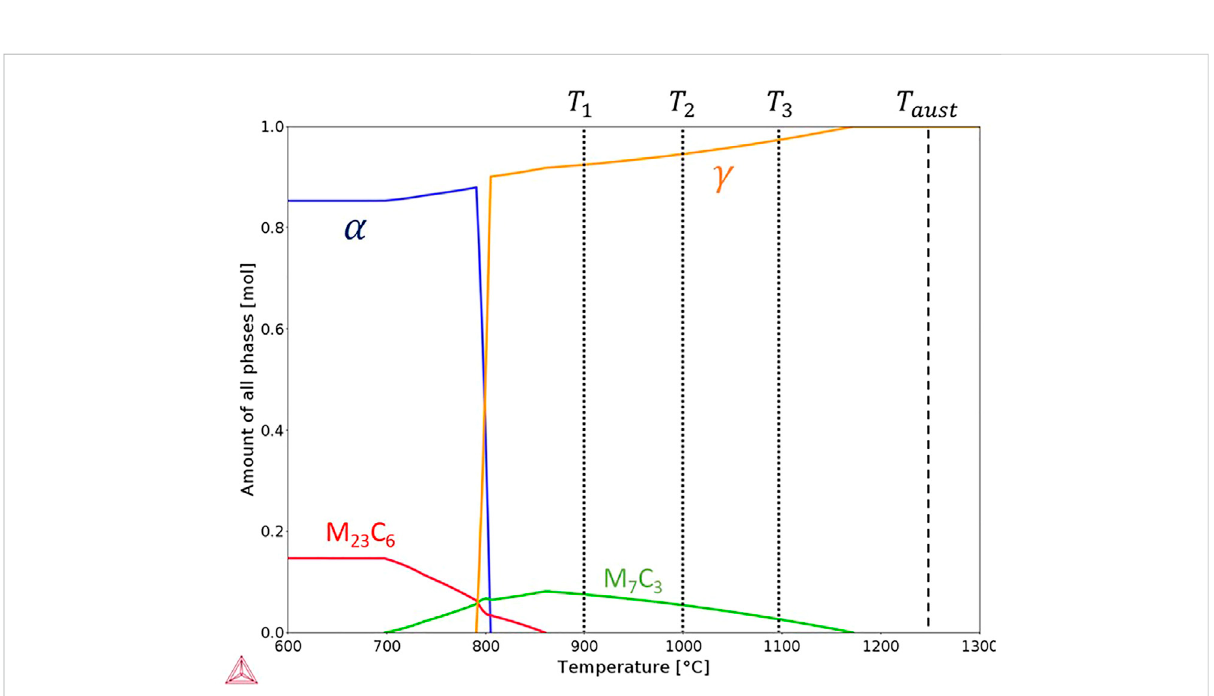
FIGURE 2 Equilibrium property diagram of Fe – C – Mn – Si – Cr computed with TCFE12. T aust is the austenitization temperature, and T i are the three holding